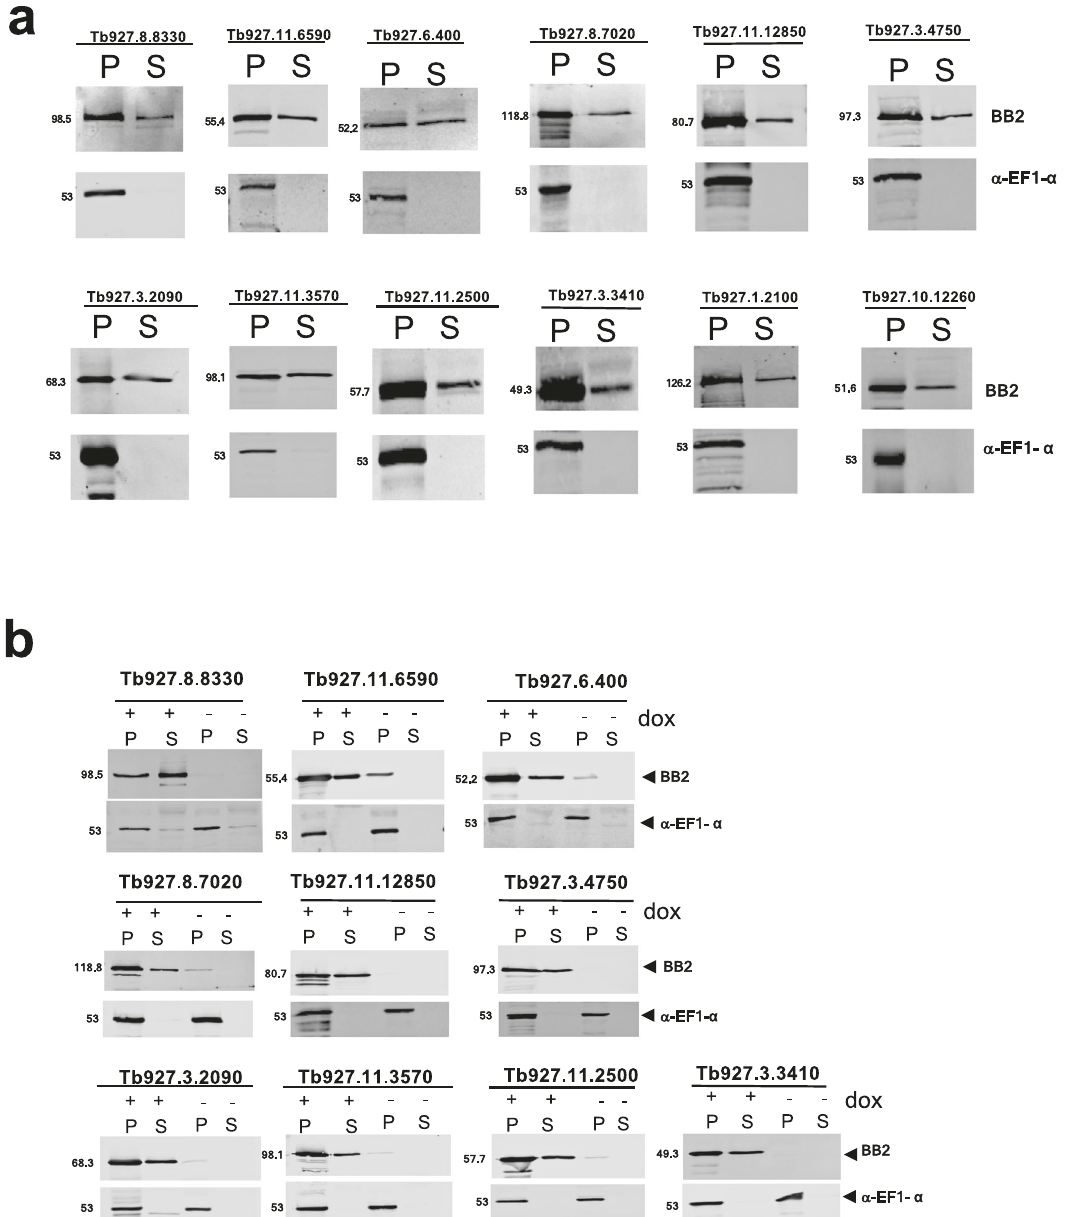
Fig. 2 Peptidases identi fi ed by mass spectrometry are released from intact trypanosomes. a Release of identi fi ed peptidases by bloodstream form parasites. In each case, the identi fi ed peptidase was epitope tagged using constructs targeting the endogenous gene locus to ensure close to physiological expression. Resultant cell lines were assayed in serum-free Creek ’ s medium for 2 h and then the cell pellet (P) and supernatant (S) isolated by centrifugation. Isolated proteins were monitored for the distribution of each peptidase using the BB2 antibody detecting the Ty1 epitope tag, with the abundant cytosolic protein EF1-alpha used to monitor non-speci fi c escape of cytosolic proteins. Molecular weight markers in kDa. b Inducible ectopic expression of each peptidase identi fi ed as released by parasites. In each case, N-terminally epitope-tagged genes were cloned into a doxycycline-inducible expression vector and then the expression and extracellular release of the expressed proteins were monitored using the epitope tag-speci fi c antibody BB2, with the cytosolic protein EF1-alpha used as a control. Released and cell-associated proteins were isolated after incubation of parasites in serum-free Creek ’ s medium for 2 h and centrifugation. Molecular weight markers in kDa. Source data are provided as a source data fi